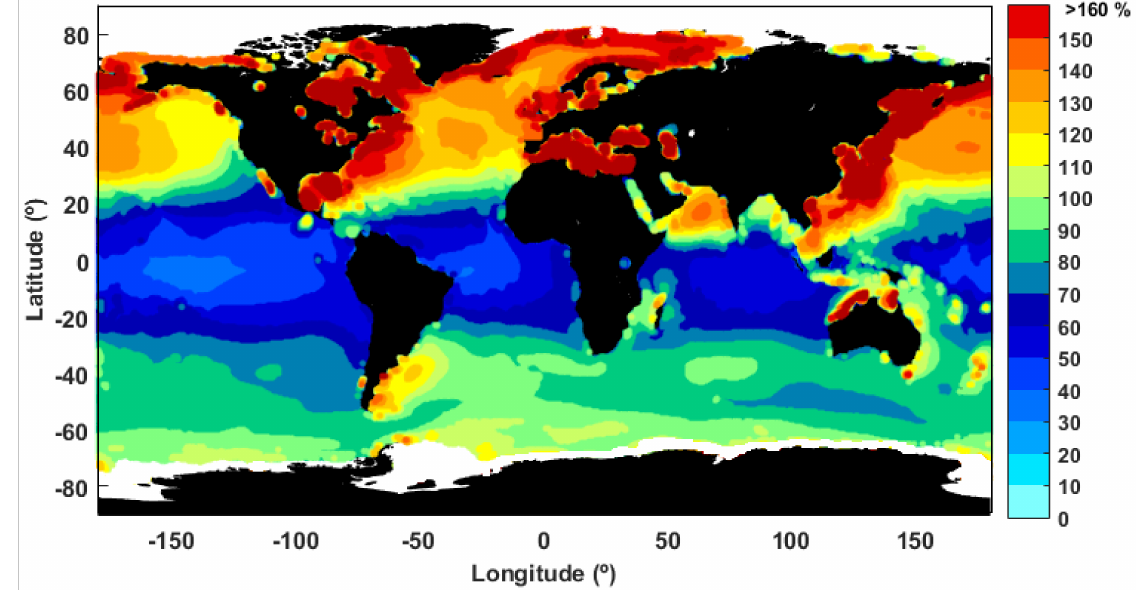
Figure 5. Mean annual variability (MAV) for wave power over the 30-year time interval